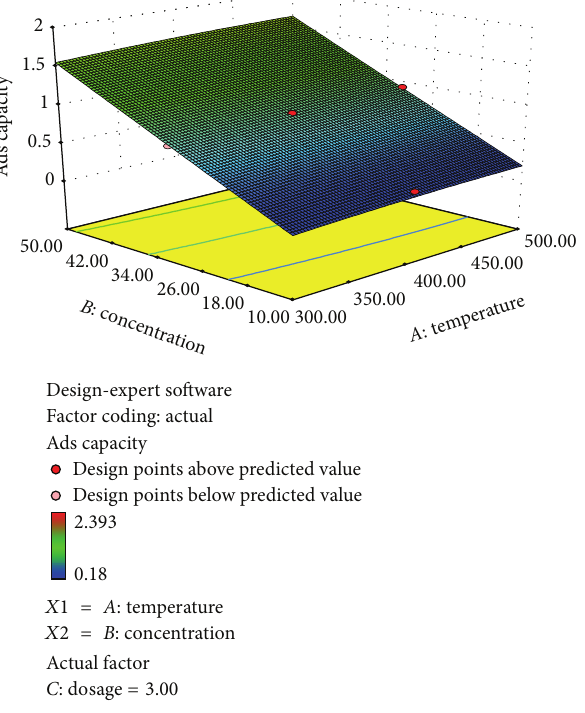
Figure 4: Combined effect of factors 𝐴 - 𝐵 on response 𝑌 2 . Figure 5: Combined effect of factors 𝐴 - 𝐶 on response 𝑌 1 .